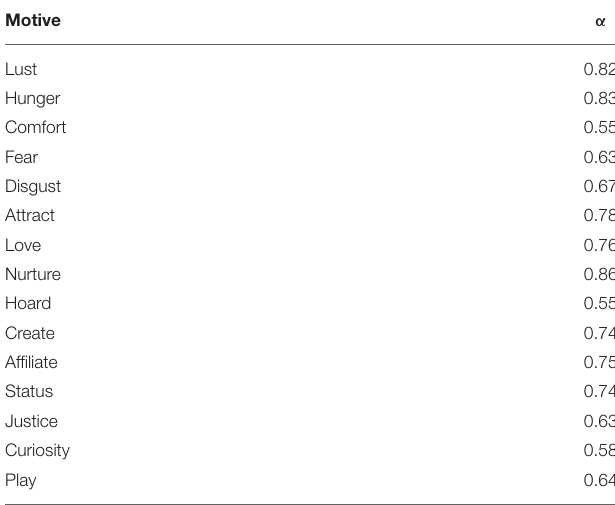
TABLE 5 | Internal consistency values by